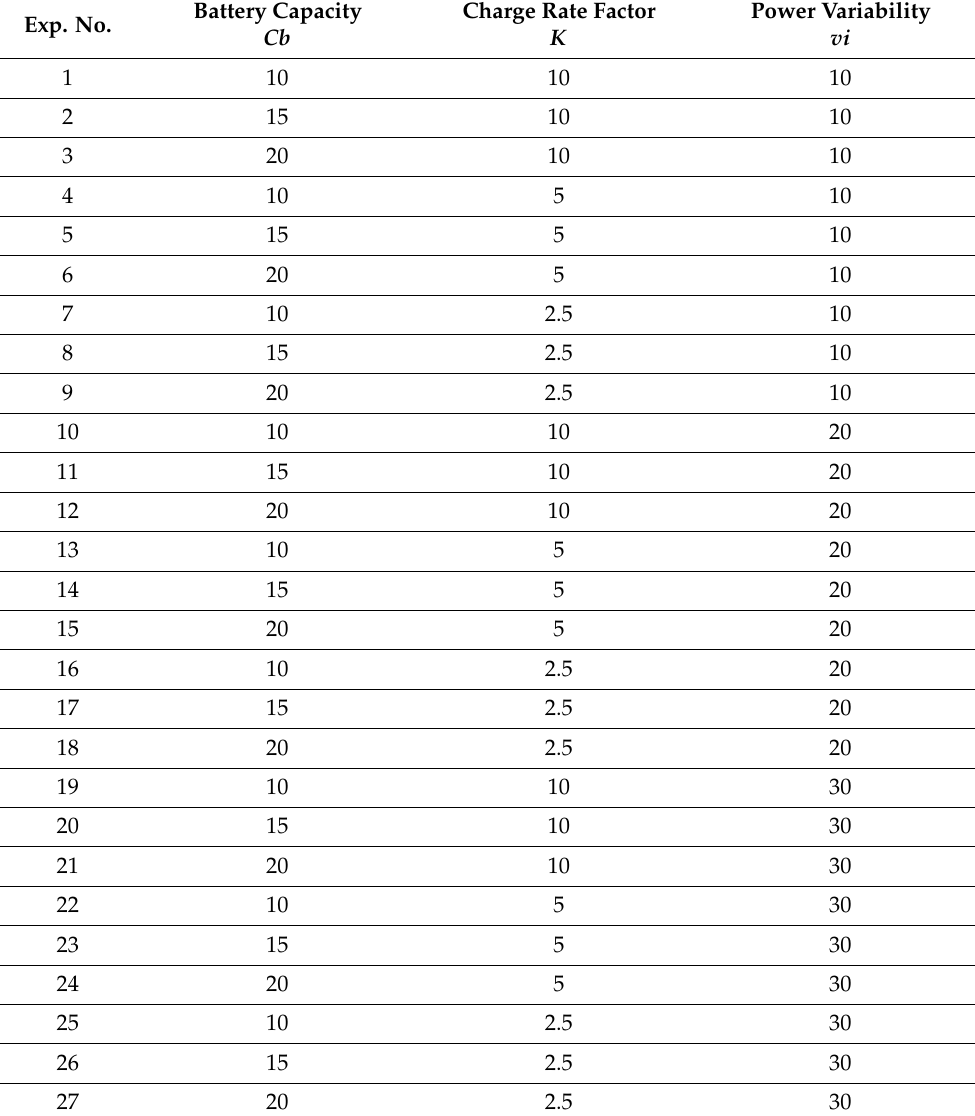
Table 1. Experimental